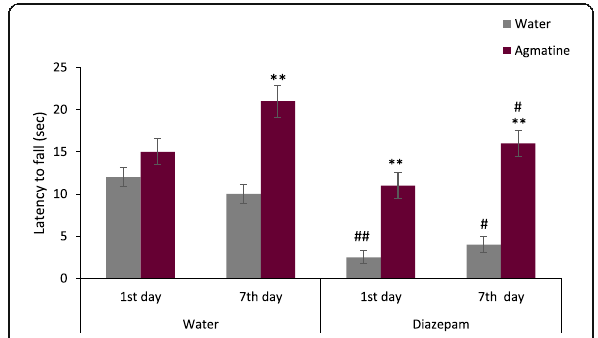
Fig. 6 Inverted screen test: Values are expressed as means ± SD (n = 12). Significant differences by Newman-Keuls test: ** p < 0.01 from control group to agmatine-treated groups. ## p < 0.01, # p < 0.05 from water-pretreated animals to respective withdrawal animals following II-way ANOVA